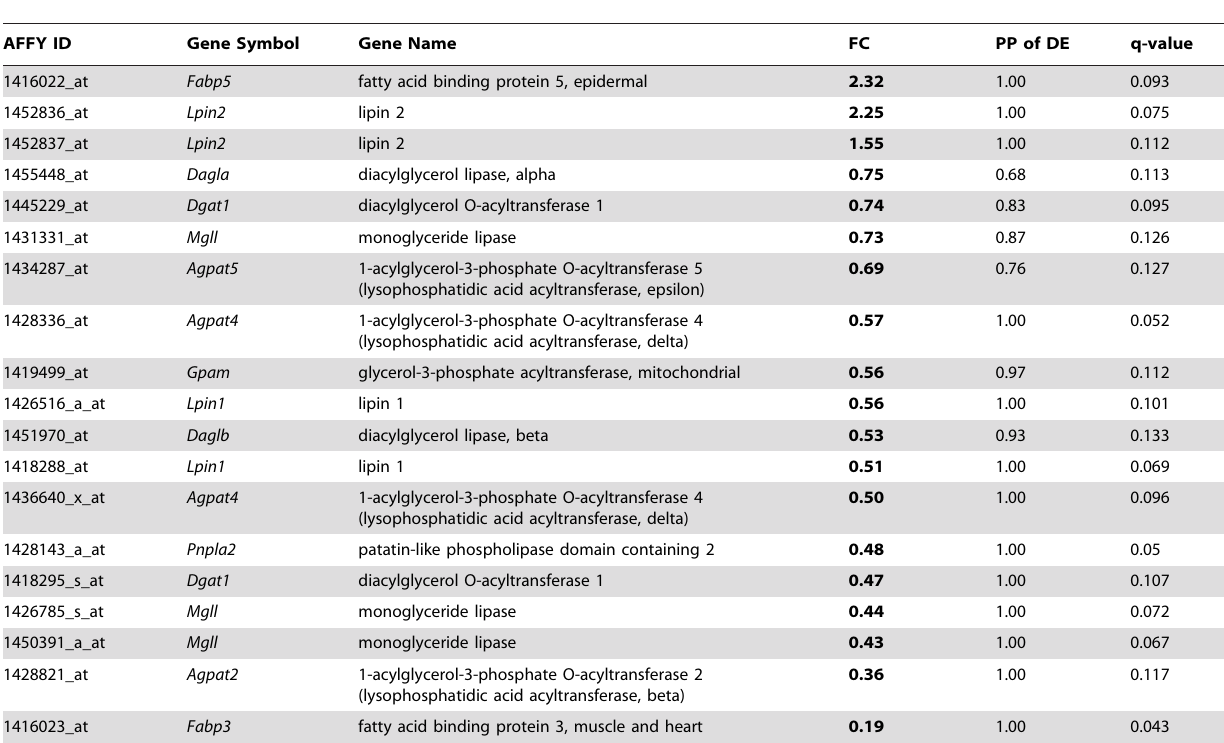
Table 9. Acyltransferases, fatty acid binding proteins and lipases.